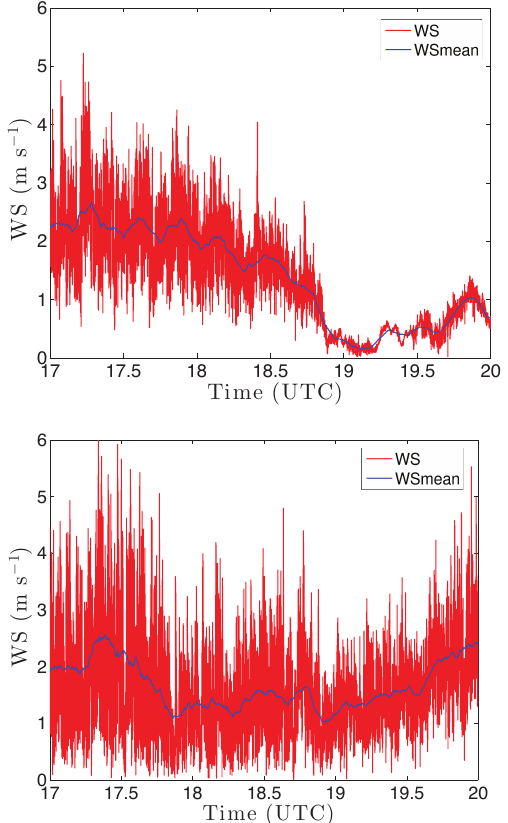
Figure 7. Temporal evolution of mean wind speed and deviation from mean wind speed on 24 (top) and 27 June 2011